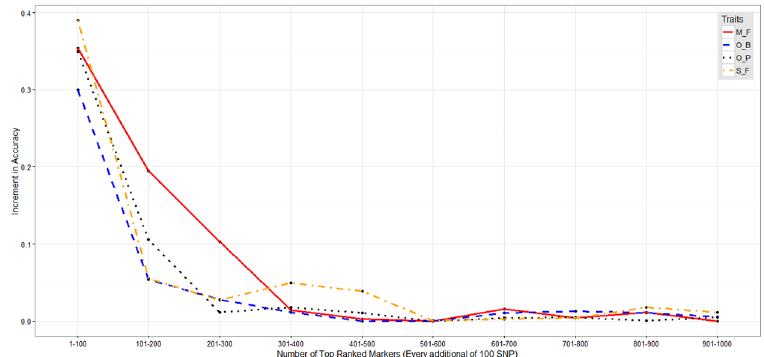
Figure 5. Prediction accuracy increment for every additional 100 SNP for M/F, S/F, O/B and O/P